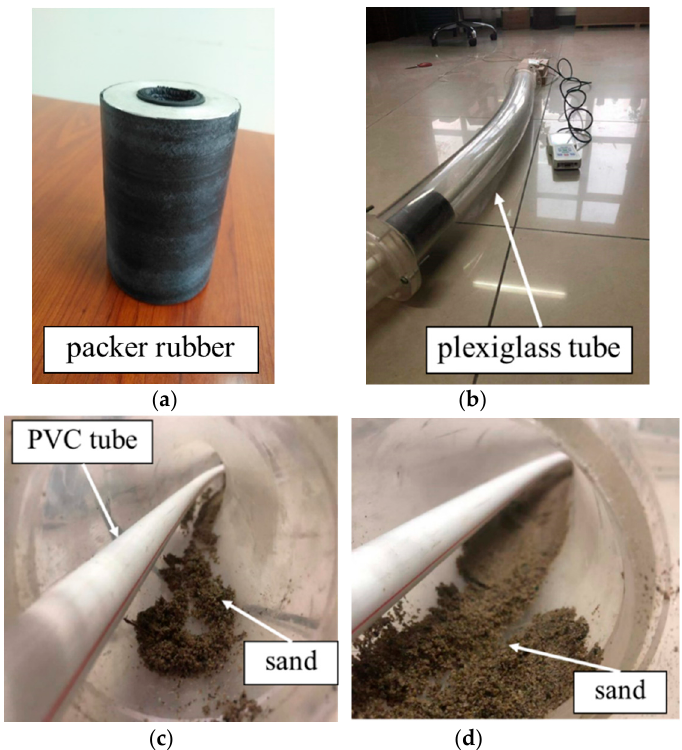
Figure 3. Schemes of the completion string with a packer in the deviated hole: ( a ) The simulated packer; ( b ) the completion string with a packer in the deviated hole; ( c ) the deviated hole with little cuttings; and ( d ) the deviated hole with lots of cuttings.